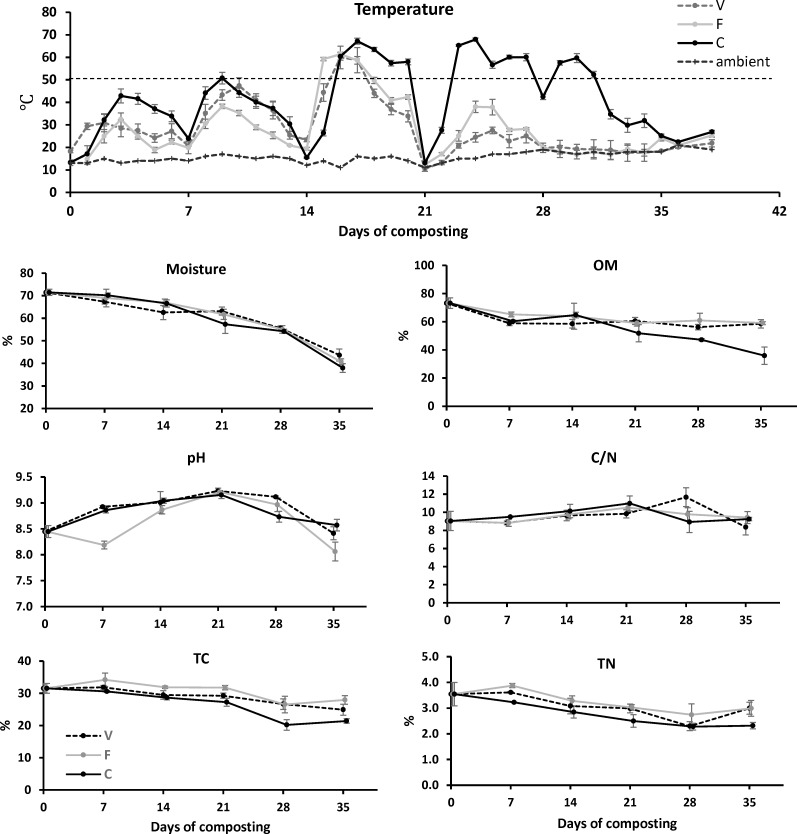
Temperature profile and moisture, organic matter, pH, C/N, total carbon and total nitrogen variation of V, F and C composts.